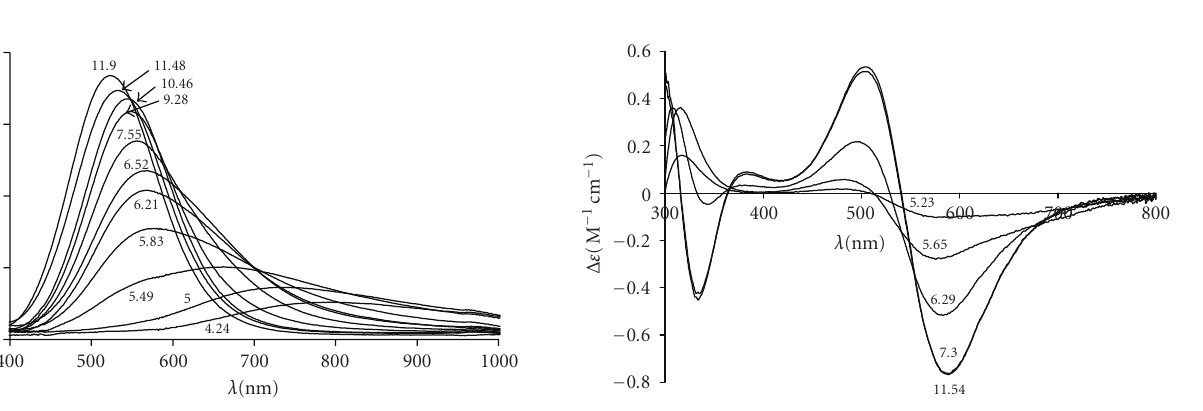
Figure 5: CD spectra of the copper(II)-VIDAH system at 2 : 1 metal ion to ligand ratios at di ff erent pH values (c L = 2 · 10 − 3 mol/dm 3